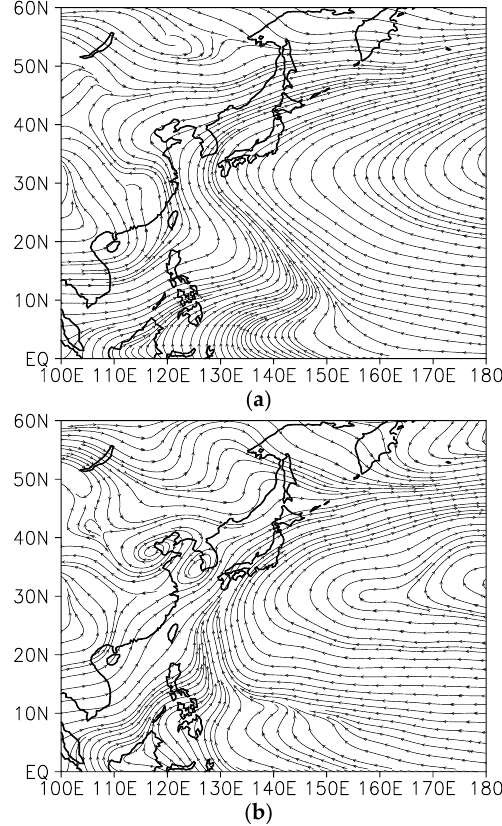
Figure 6. 850 hPa stream flows of ( a ) climatological mean and ( b ) 2014 in August.